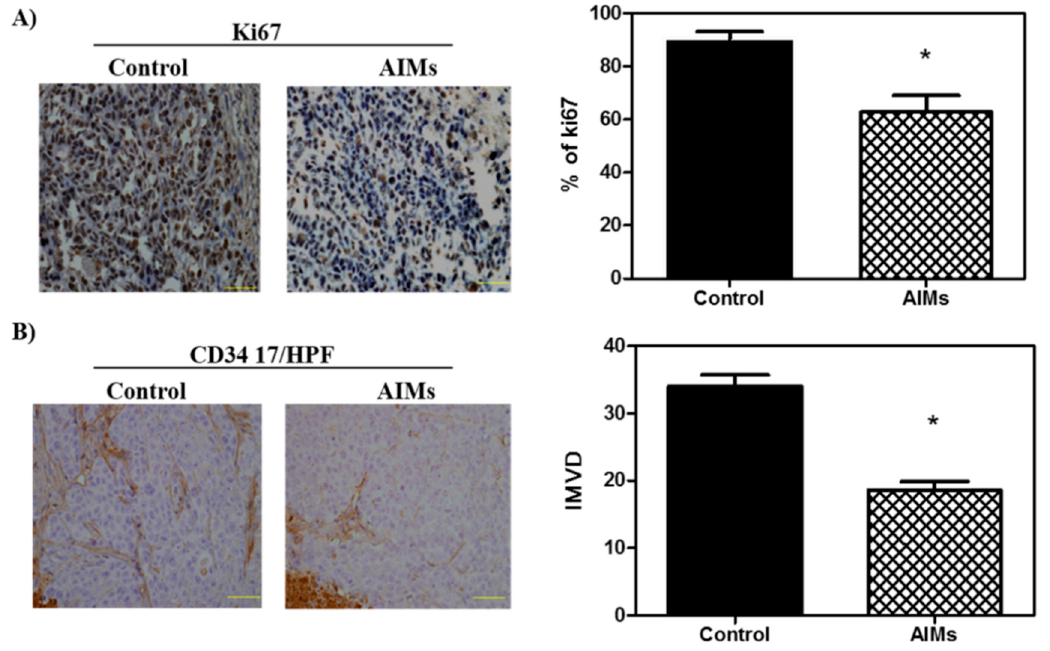
Figure 4. AIMs inhibits Ki67 expression and intra-tumoral microvessel density (IMVD) in Hep3B cell-originated tumors in athymic nude mice. ( A ) Cell proliferation was demonstrated by Ki67 immunostaining. Reduction in Ki67 staining showed that AIM treatment reduces cell proliferation.